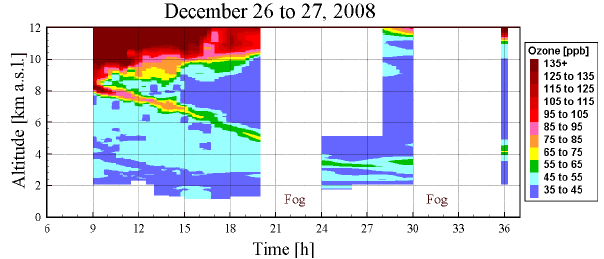
Fig. 7. FLEXPART stratospheric fractions for the period shown in Fig. 8, obtained from twenty-day Figure 7. FLEXPART stratospheric fractions for the period shown retroplume calculations; the average fractions for the first five backward days are taken. in Fig. 8, obtained from 20-day retroplume calculations; the average fractions for the first 5 backward days are taken. Figure 7 should be printed just below Fig. 6!